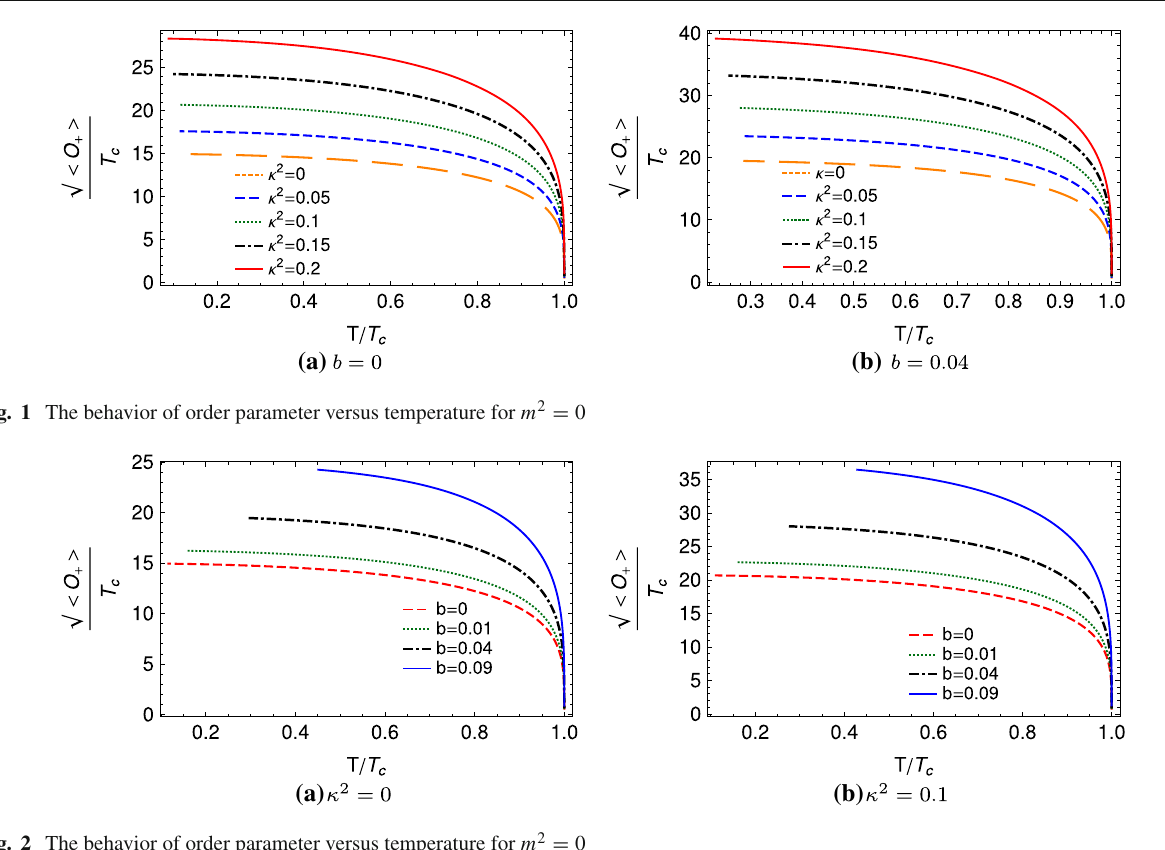
Fig. 2 The behavior of order parameter versus temperature for m 2 =